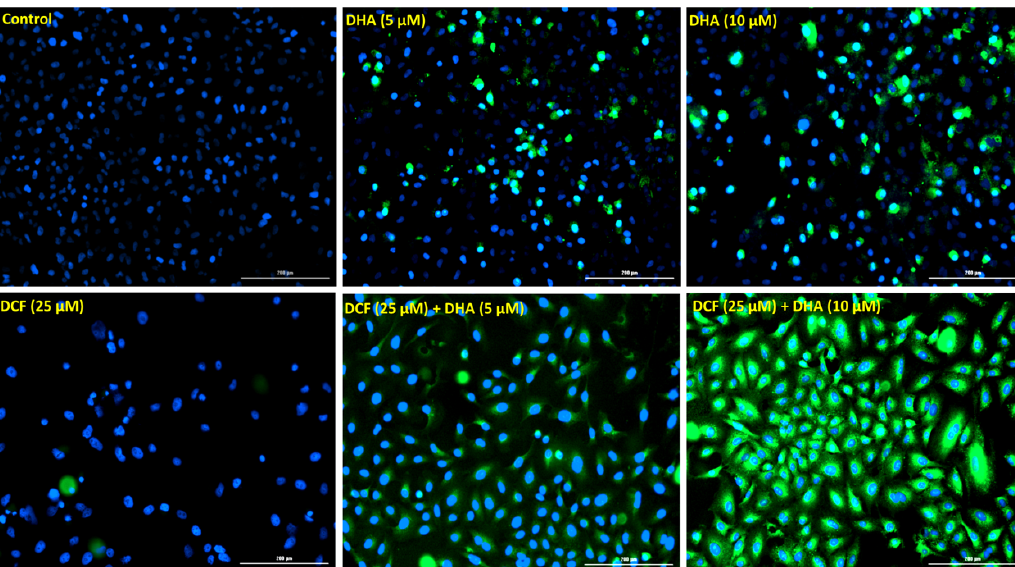
Figure 6. Co-treatment with DHA and DCF induced caspase 3/7 activation in A549 cells. Caspase 3/7 activation was observed after treating A549 cells with DHA and DCF for 48 h and then reacting with the fluorescent caspase 3/7 irreversible inhibitor (green FLICA). Images were taken with the Cytation 1 Cell Imaging Multi-Mode Reader (magnification ×10).